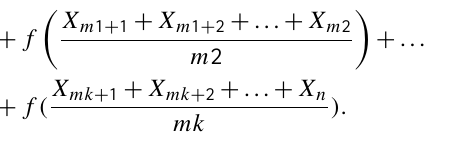
Fig. 10. Sub-basins selected for inverse extrapolation. The green- Figure 10. Sub-basins selected for inverse-extrapolation. The green-outlined small basin, with 3 outlined small basin, with an area of 2250km 2 , is found to have similar climate conditions as the selected cells (red, 21228km 2 in an area of 2250 km 2 , is found to have similar climate conditions as the selected cells (red, 4 total) of two larger 21228 km 2 in total) of two larger sub-basins. 5